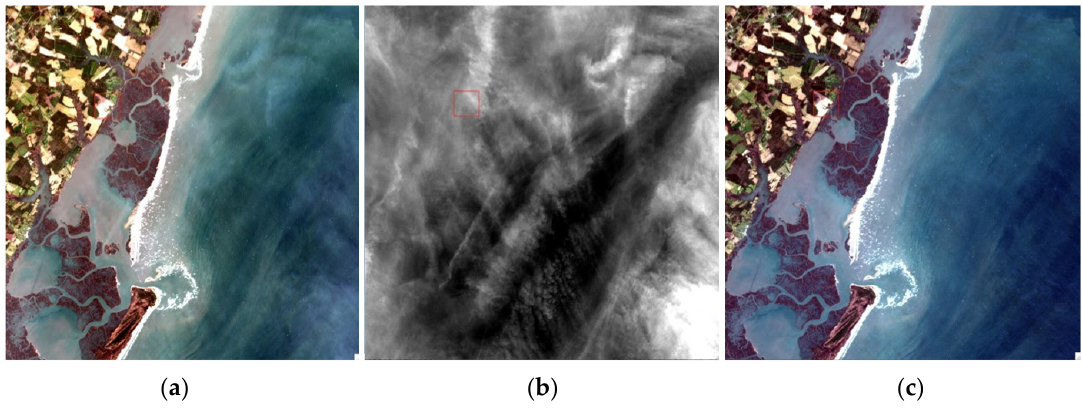
Figure 7. ( a ) A Landsat 8 OLI RGB image acquired over Delaware in the eastern United States on 17 April 2014; ( b ) The Band 9 (cirrus) image; ( c ) The cirrus-corrected RGB image.